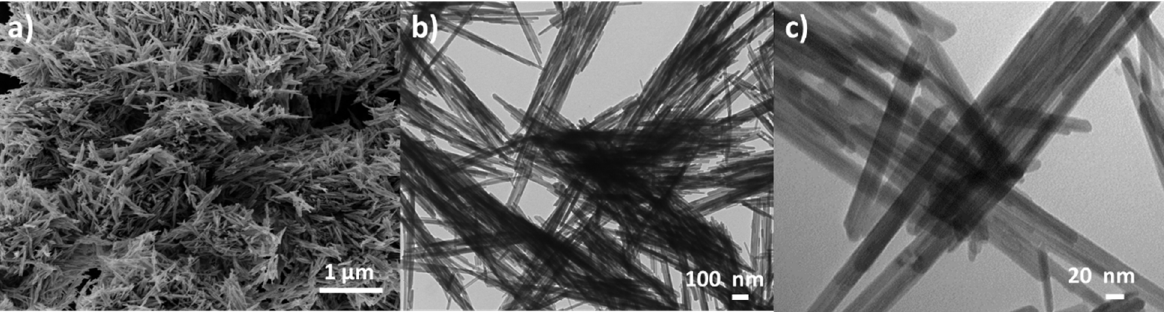
Figure 6. SEM image ( a ) and HR-TEM images ( b , c ) of pure K–OMS–2 material (unpublished results). As an example, Liu et al. [107] reported that K–OMS–2 could be obtained with con- trolled particle sizes varying from 8.2 to 61.1 nm in width and from 35.6 to 1376.1 nm in length by reacting KMnO 4 with different carboxylic acids